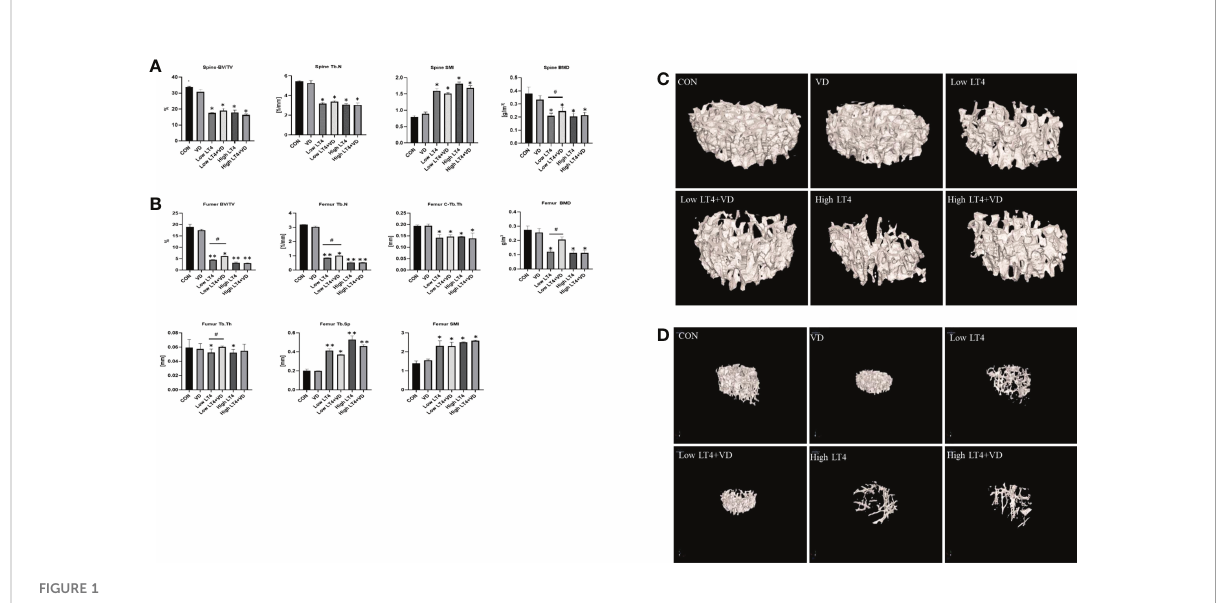
FIGURE 1 Bone loss and inhibition via treatment with vitamin D in mice with thyrotoxicosis. The fourth vertebra and the femur in the CON, VD, Low LT4, Low LT4+VD, High LT4 and High LT4+VD groups were determined by micro-CT. (A) Trabecular BV/TV, Tb. N, SMI and BMD of the spine. (B) BV/TV, Tb. N, C-Tb. Th, BMD, Tb. Th, Tb. Sp and SMI of the femur. (C) Representative 3D reconstructions of the trabeculae. (D) Representative 3D reconstructions of the femur. (A, B) Data are shown as the means ± SEMs (n=6). Compared with the CON group. * P < 0.05, ** P < 0.01. Compared with the Low LT4 group, # P < 0.05.